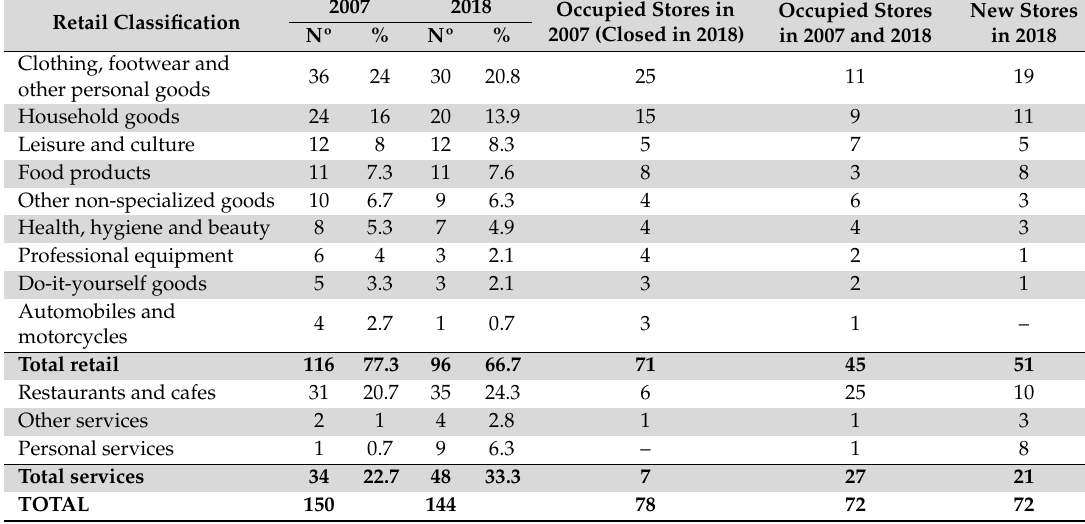
Table 1. Evolution of the retail fabric of the area surrounding Campo de Ourique